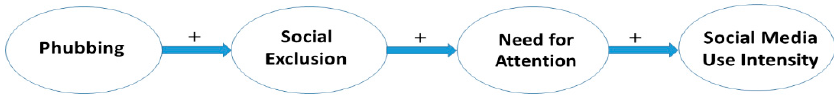
Figure 1. Sequential Mediation Model Tested Based on David and Roberts